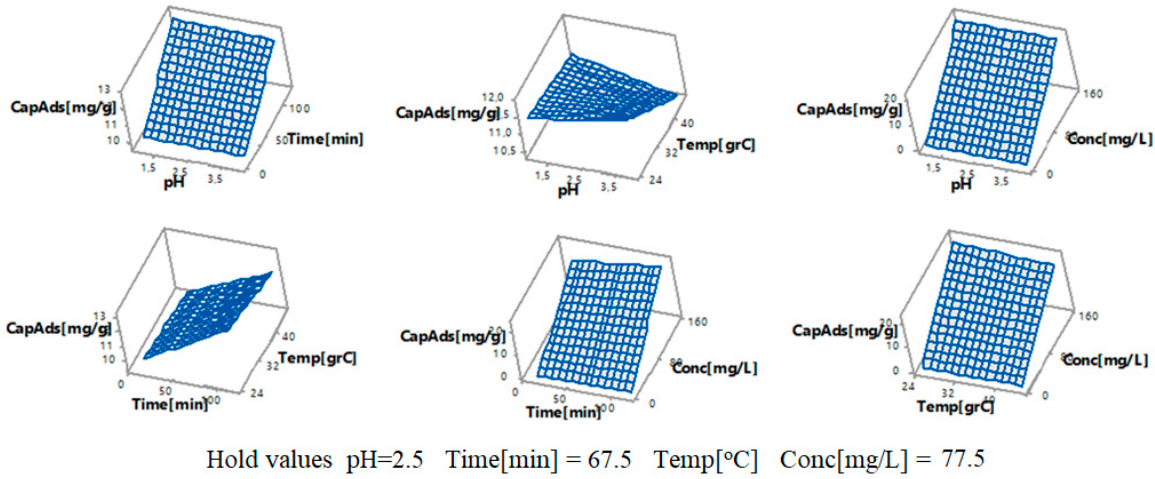
Figure 8. 2D contour curves for the interaction ( a ) time × pH, ( b ) temperature × pH, ( c ) concentration × pH, ( d ) temperature × time, ( e ) concentration × time, and ( f ) concentration × temperature when the response is the adsorption capacity.